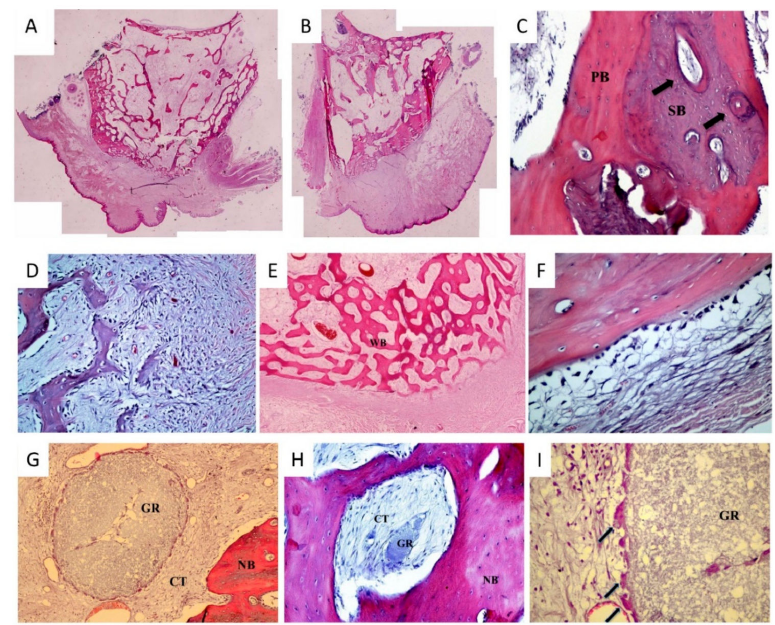
Figure 4. Representative histological pictures (H&E staining). ( A ) Site grafted with the resorbable alloplastic biomaterial at 12 weeks. The site is filled with regenerated bone, bone marrow and connective tissue. At the periphery of the socket, native cortical bone can be identified in continuity with the newly formed cancellous bone in the center. At this time point, most of the easy-graft CLASSIC particles have been resorbed; ( B ) Nongrafted extraction site at 12 weeks. Regenerated bone showing active remodeling; ( C ) At the center, mature secondary bone (SB) with harversian systems (arrows) can be observed, surrounded by less mature primary lamellar bone (PB). These types of bone are clearly separated by cement or reversal lines; ( D ) Newly formed bone trabeculae with osteoblast lining at the periphery, and connective tissue with numerous mesenchymal cells; ( E ) Newly formed woven bone (WB) sealing the entrance of the extraction socket; ( F ) Periosteum-like connective tissue covering